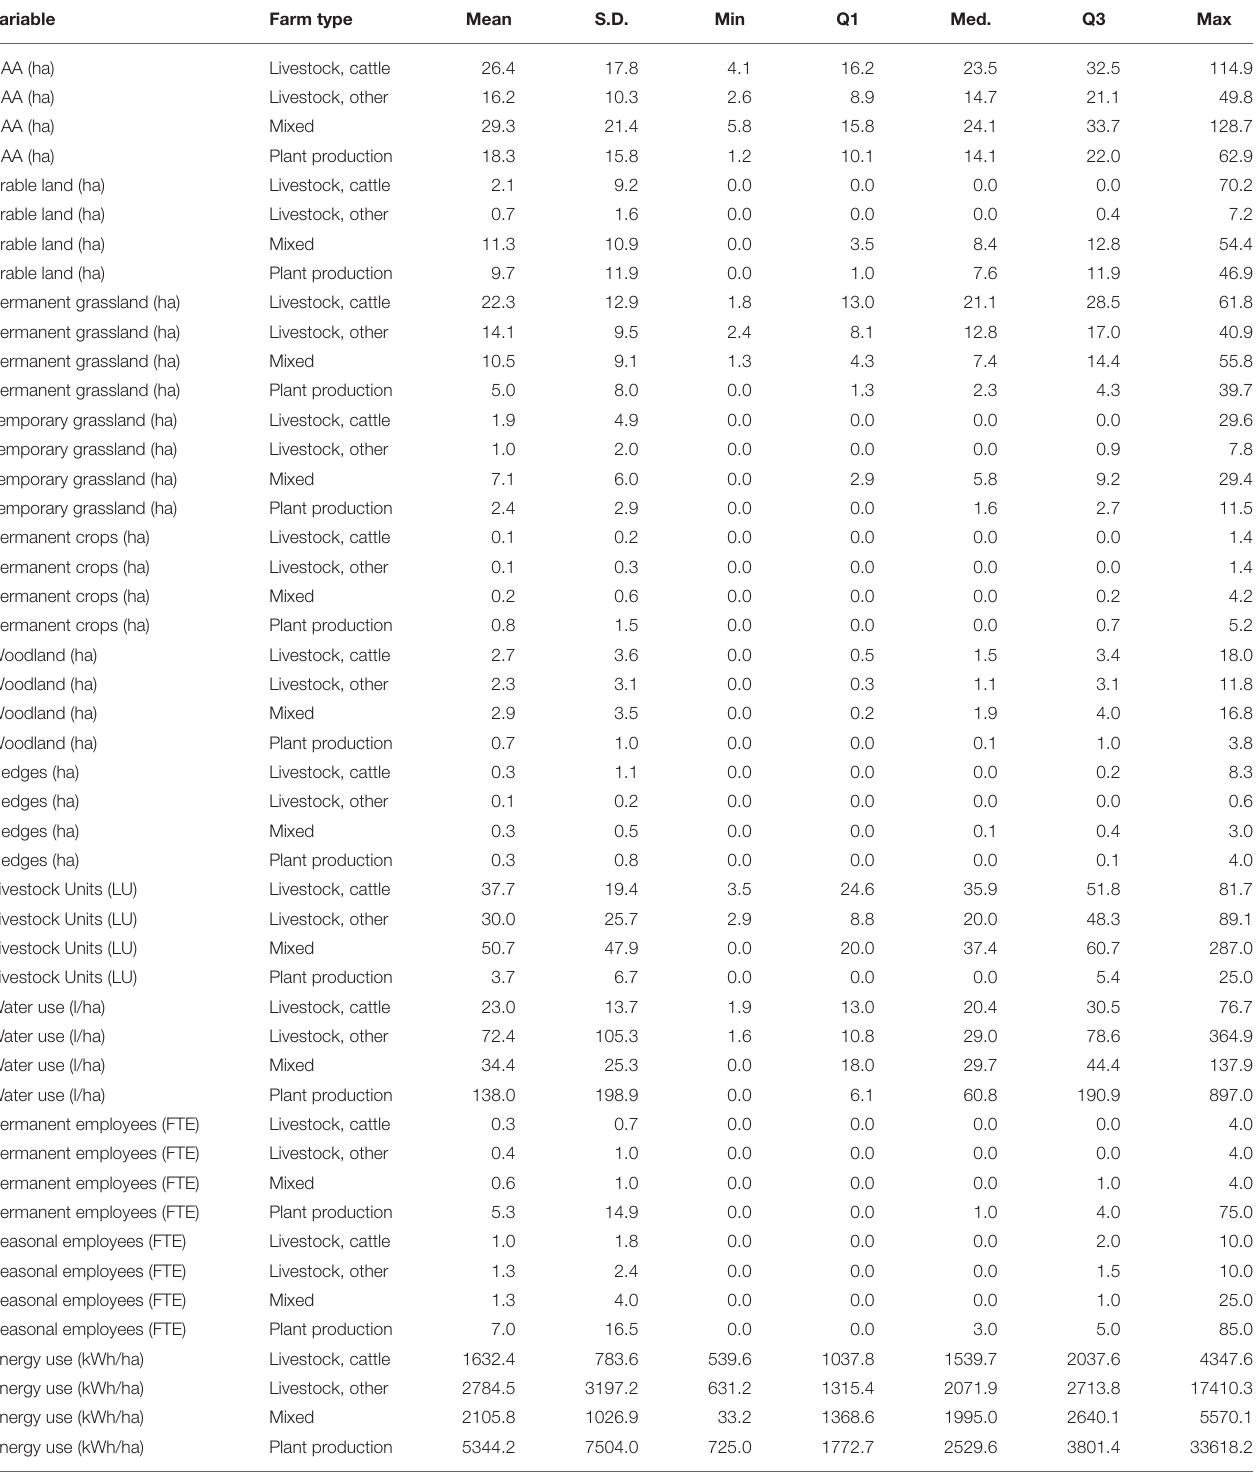
TABLE 1 | Summary statistics of the sampled farms by simplified farm type.